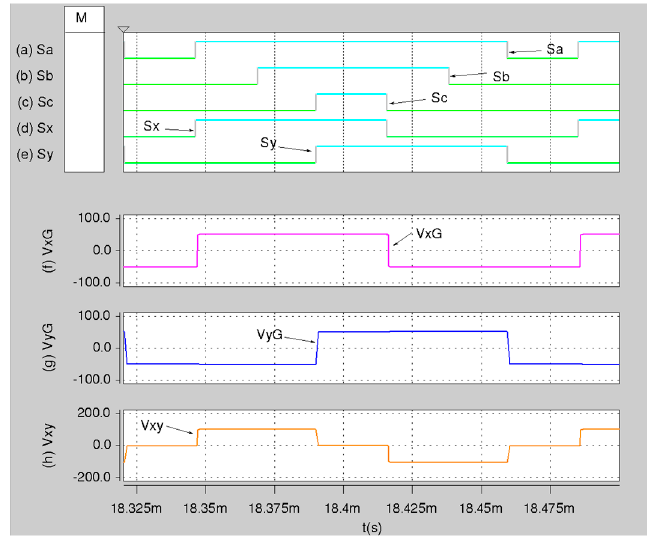
Figure 17. Simulations results: conventional switching states ( a ) S a , ( b ) S b and ( c ) S c ; H-bridge switching states ( d ) S x and ( e ) S y and voltages ( f ) v xG ( g ) v yG and ( h ) v xy . Supply: 127 V, 60 Hz, Output: 100 V, 5 kW.